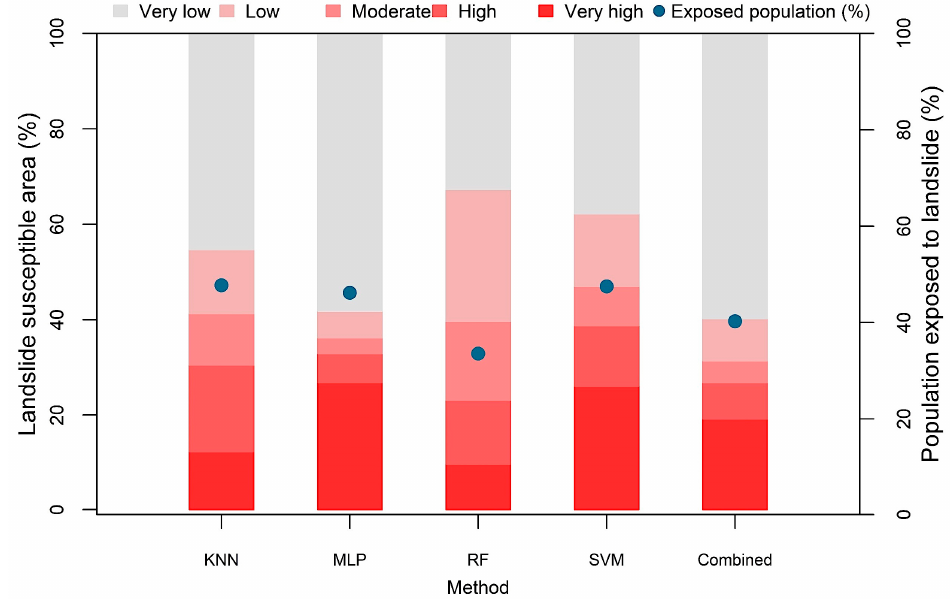
Figure 6. Landslide susceptible area obtained using five models: K-Nearest Neighbor (KNN), Multi-Layer Perceptron (MLP), Random Forest (RF), Support Vector Machine (SVM), and combined model. Blue dots indicate the proportion of people exposed to ‘high’ and ‘very high’ susceptible zones.